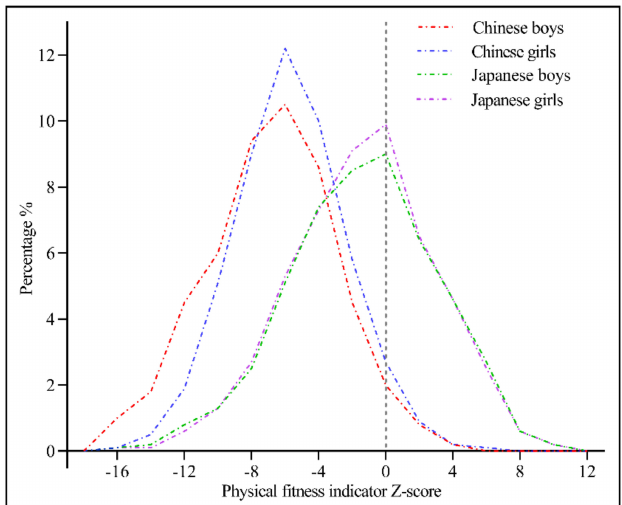
Figure 4. Physical fitness index distribution curves for children and adolescents by gender in China and